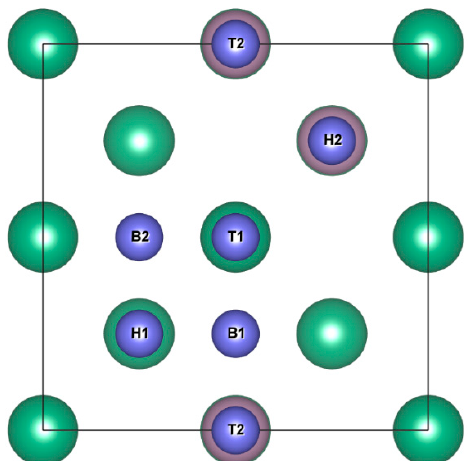
Figure 4. Schematic illustration of three possible locations of hydrogen atoms adsorbed onto Mo-doped Nb (100) surface: top site (T1, T2), bridge site (B1, B2), and hollow site (H1, H2).